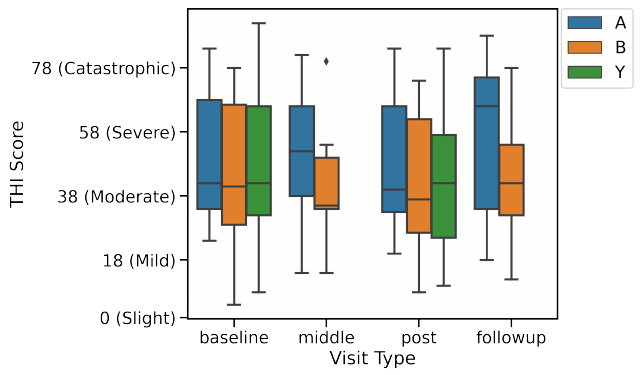
Figure 8. THI Score during baseline, mid-study, post-study and follow-up visits for groups A, B and Y.